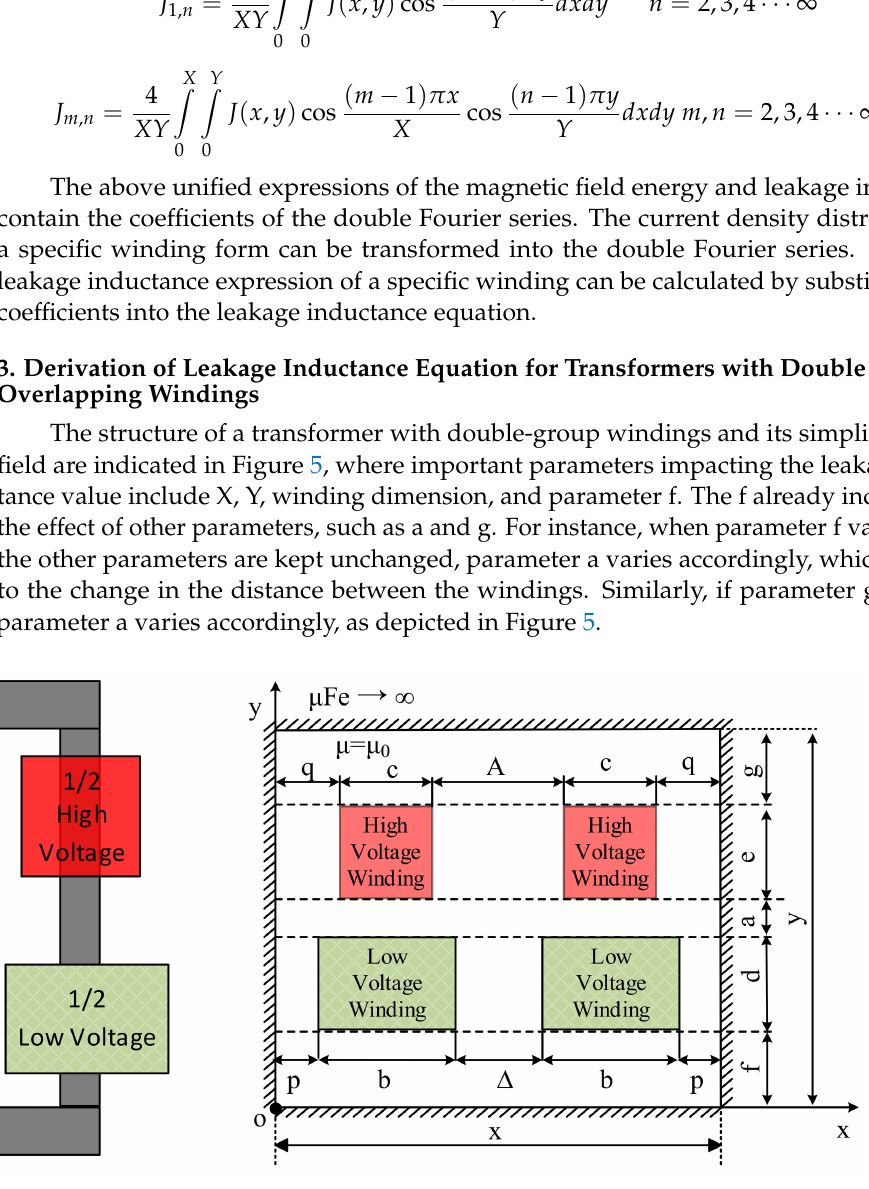
Figure 5. The simplified plane field of a transformer with double-group